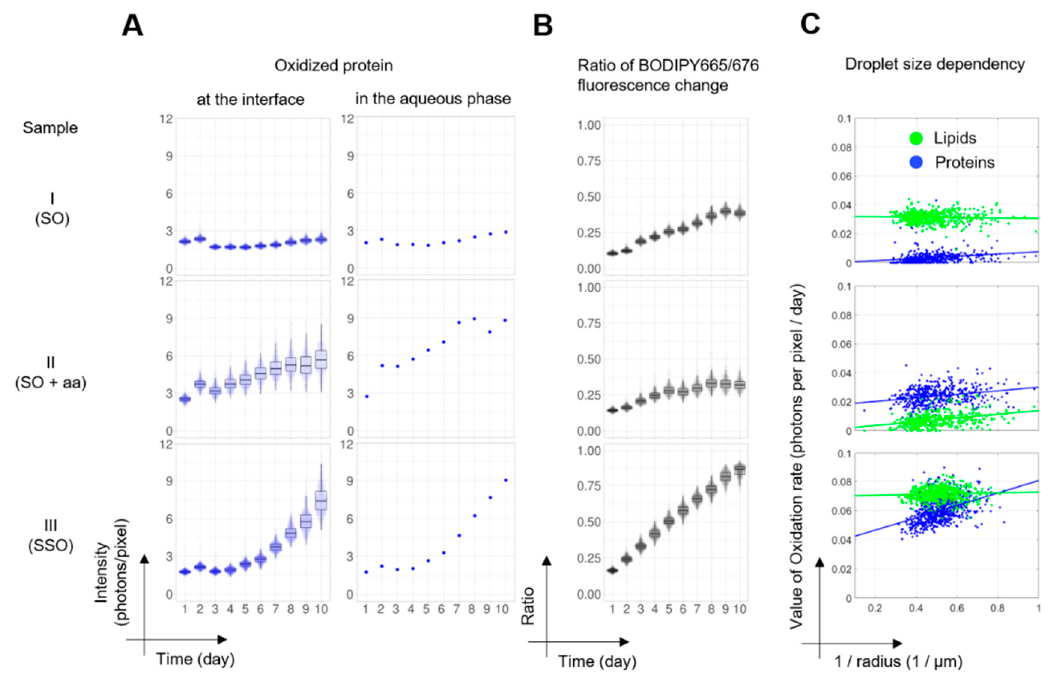
Figure 3. Statistical analyses of protein and lipid oxidation. ( A , B ) The data are visualized using PlotsOfData [33]. Each data point represents the average intensity of individual droplets. Black boxes indicate the 95% confidence interval (95CIs) of the data and the center line indicates the median value. ( A ) Intensity changes of protein oxidation at the interface and the aqueous phase. For the numbers of analyzed droplets (left column), see Table 2; for the aqueous phase (right column), we obtained a single number from the entire field of view. ( B ) The ratio of BODIPY 665 / 676 fluorescence intensity changes is presented as a measure of lipid oxidation. The averaged intensity per droplet from λ ex 561 nm (oxidized lipids) was divided by the sum intensity from λ ex 640 nm (non-oxidized lipids) and λ ex 561 nm (oxidized lipids). ( C ) The e ff ect of the inverse droplet size (surface to volume) on the oxidation rate of lipid within droplets (green color) and protein at / near interfaces (blue color) based on changes in fluorescence intensity. Dots show the local lipid oxidation rate as obtained from fitting the time dependency of BODIPY 665 / 676 color shifts and protein fluorescence changes in individual droplets with the Gompertz function. Lines show the regression analysis result of local lipid (green line) and protein (blue line) oxidation rates on the inverse of droplet sizes (see Supplementary Materials Tables S3–S5).